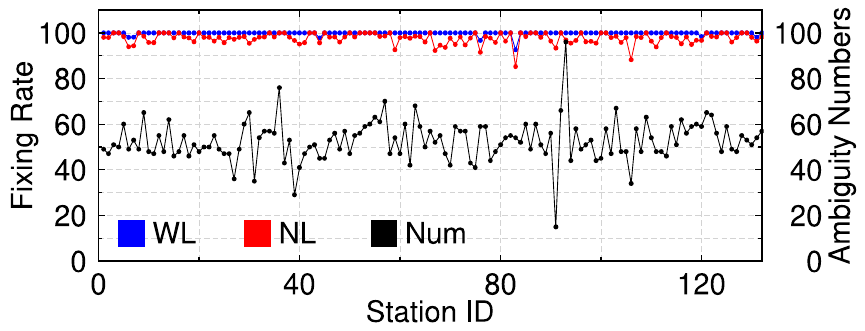
Figure 7. Ambiguity fixing rate and ambiguity numbers of IGS stations on DOY 002 with PPP method.